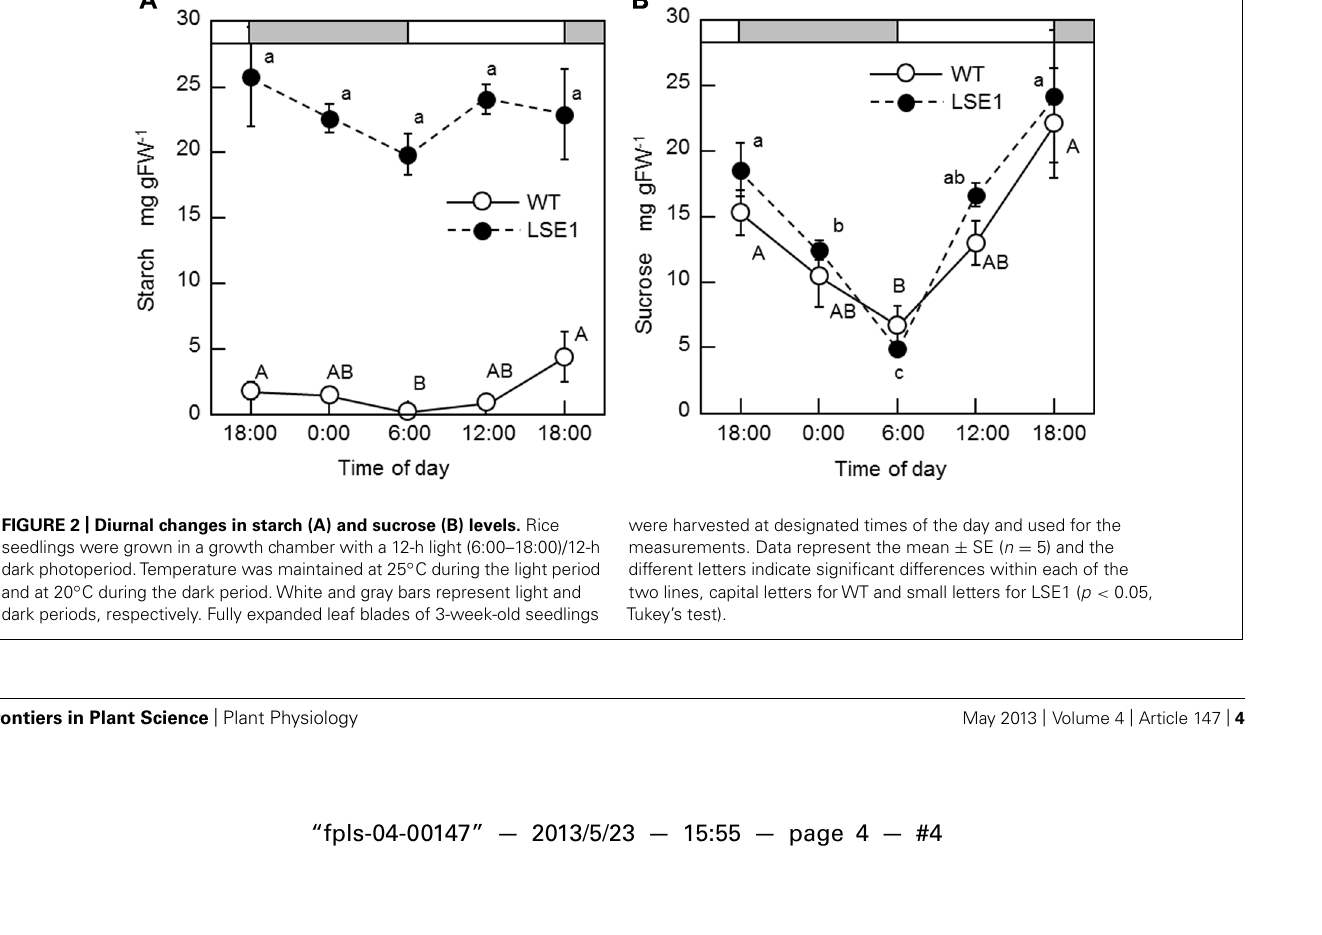
on the M1 generation plants, they segregated into stain-positive and stain-negative plants. The progeny of these M2 plants were further tested for leaf starch accumulation, and in the M3 genera- tion, the progeny of some stain-negative M2 plants segregated into stain-positive and stain-negative ones at a ratio of 1:3, suggesting that the LSE phenotype was due to the recessive mutation of a